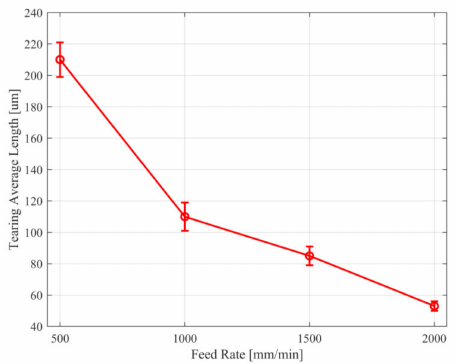
Figure 11. The effect of tool feed rate on surface